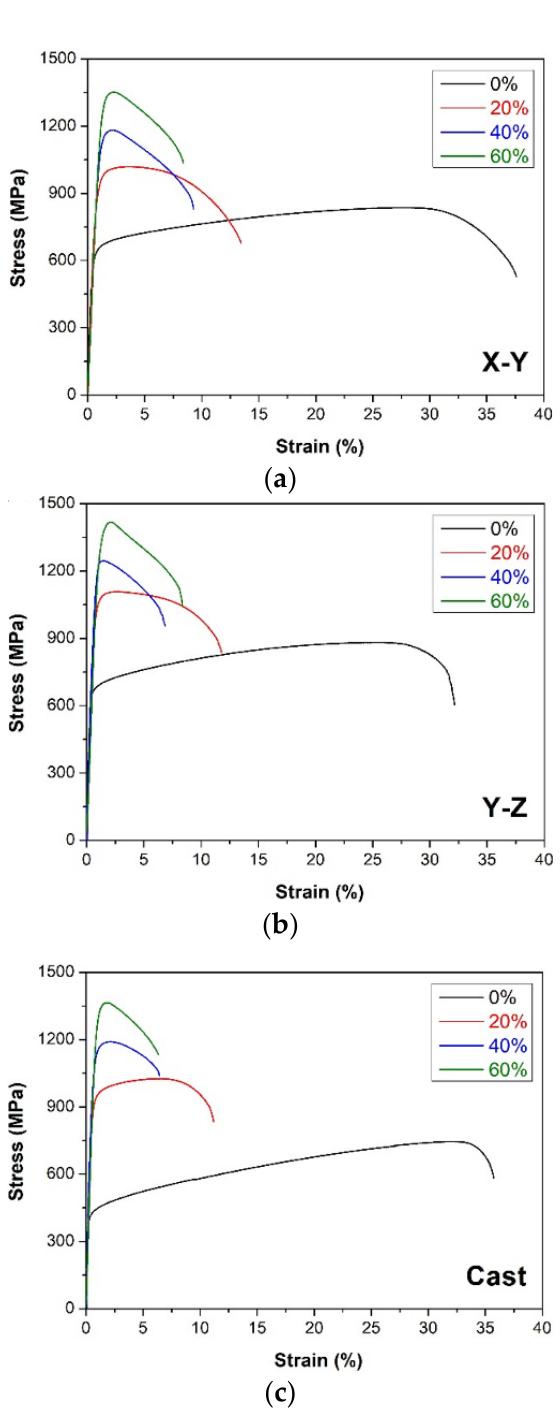
Figure 8. Stress–strain curves of ( a ) DMLS samples of Haynes 282 built in the X-Y direction; ( b ) DMLS samples of Haynes 282 built in the Y-Z direction; ( c ) as-cast Haynes 282. The black curves represent the results for the samples in the initial state, the red curves are for the samples after 20% deformation, the blue curves for the samples after 40% deformation, and the green curves for the samples after 60% deformation. Table 3. Mechanical properties of DMLS and as-cast Haynes 282 after plastic deformation.